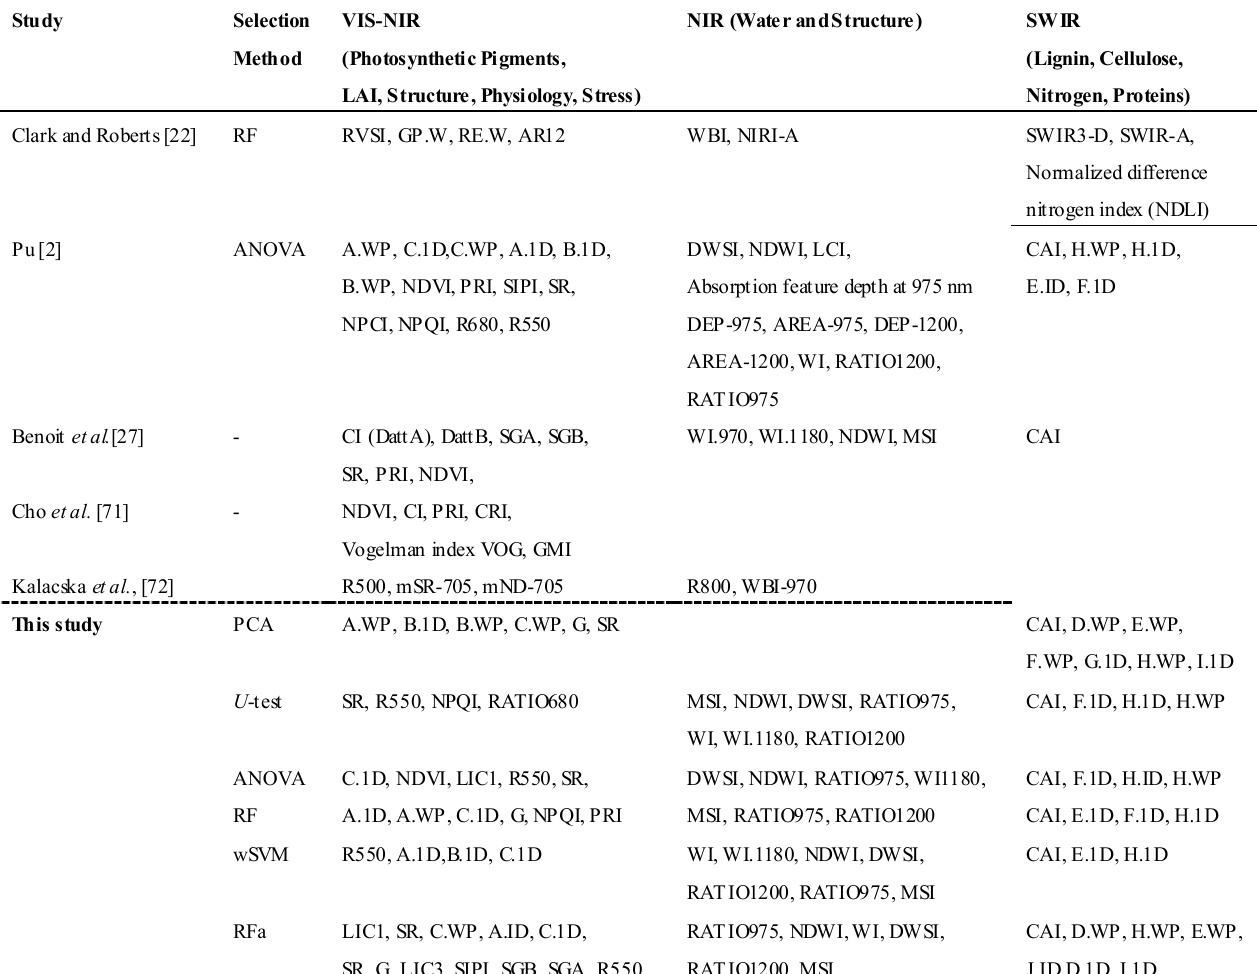
Table 5. Comparison of selected spectra indices between previous studies and this study used for species